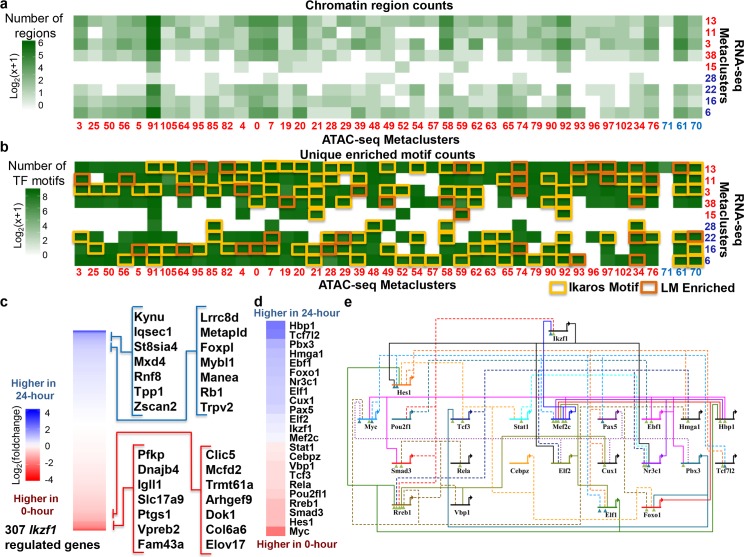
Transcriptional regulation by Ikzf1 recovered using linked SOMs.(A) Size of pair–wise metaclusters that contain both differentially–expressed genes and differentially–accessible chromatin sites. Metaclusters of genes and regions with a higher enrichment at 24–hours are colored blue and are ordered by enrichment in the two time points. (B) Number of statistically–significant motifs found in each pair–wise metacluster from (a). Presence and enrichment of the Ikzf1 motif in the pair–wise metacluster is noted. (C) Heatmap of expression fold change for genes predicted to be regulated by Ikzf1. Genes with the largest change between time points are noted. (D) Predicted downstream targets of Ikzf1 with significant change over the time course. Each gene is labels with the fold change between time points with the same scale as 4c. (E) Predicted gene regulatory network downstream of Ikzf1. Genes are ordered left to right by their fold change over the time course. Connections are dashed if their signal is significantly lower at the 24–hour time point. Connections at each gene are labeled by level of evidence found in existing literature. Teal triangles indicate experimental evidence and green triangles indicate previous computational prediction.